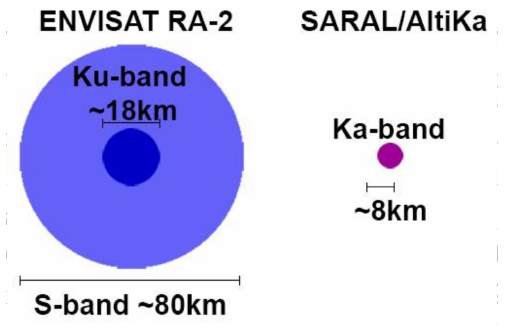
Figure A2. Size of the theoretical footprints for a totally plane surface as a function of the frequency used for ENVISAT RA-2 and SARAL